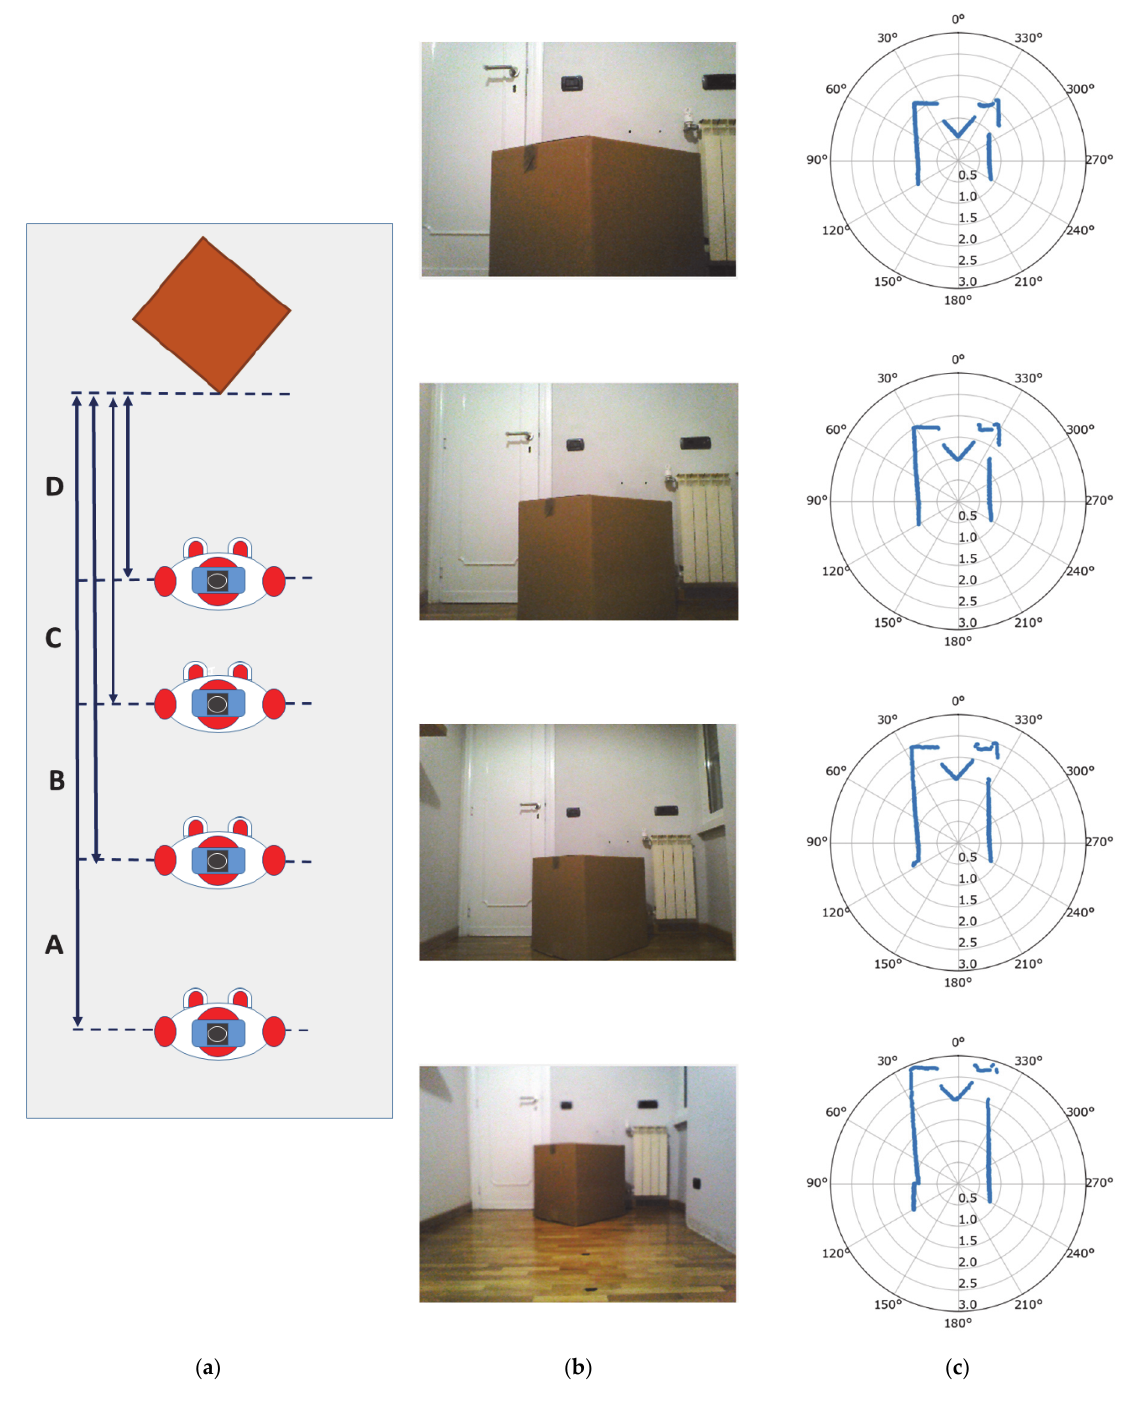
Figure 12. Test #2—scenario #1: ( a ) measurement setup, ( b ) pictures taken by the robot’s camera; ( c ) polar diagram from the data acquired by the rangefinder device at the distances of (A) 200 cm, (B) 150 cm, (C) 100 cm, and (D) 60 cm. The robot is located in the center (at coordinates 0,0) and oriented toward 0°.